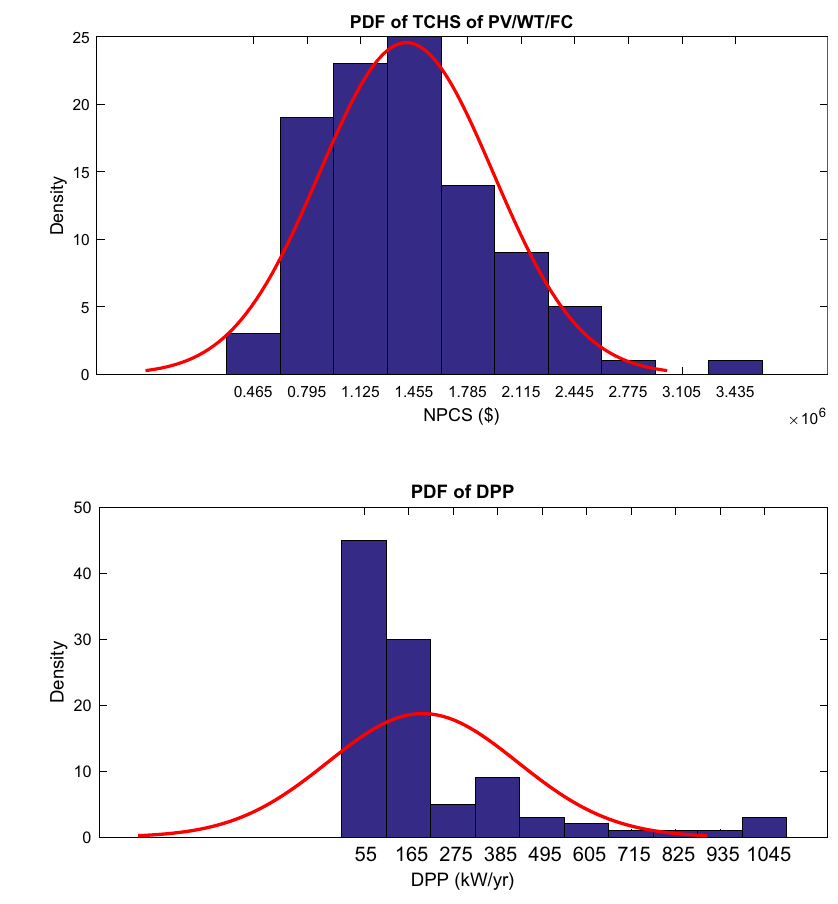
Fig. 11 PDF of DPP